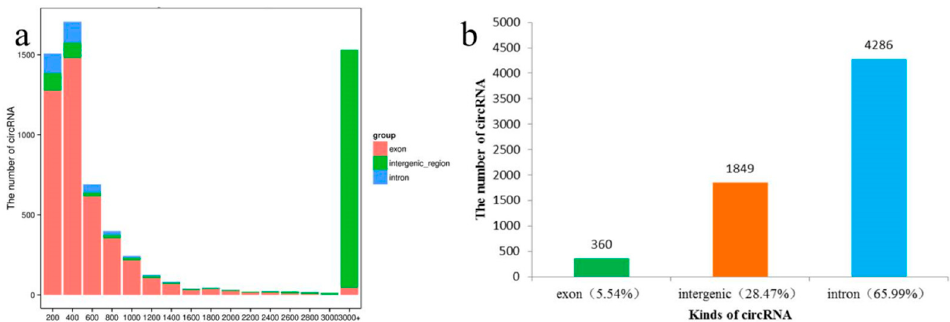
Figure 2. Screening and classification of circRNAs: ( a ) Length distribution of circRNAs identified; ( b ) Number of different kinds of circRANs identified.